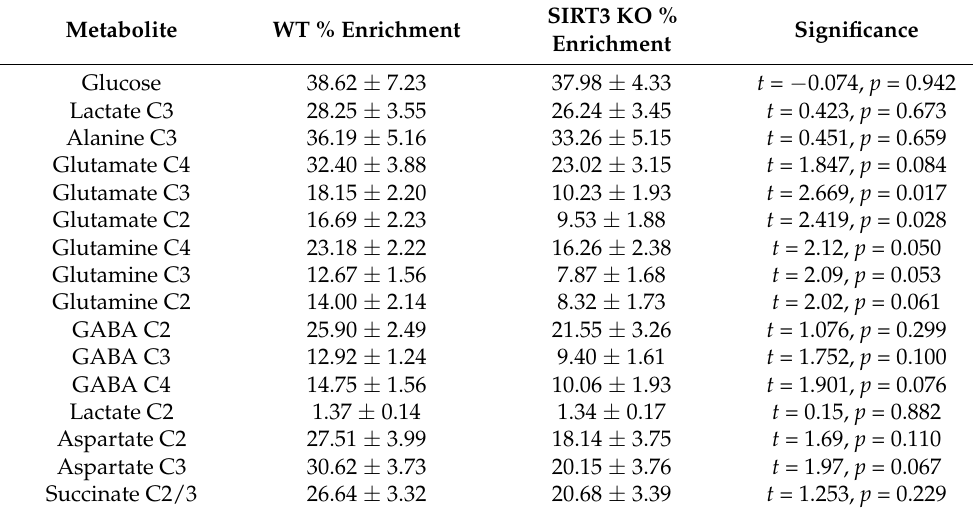
Table 1. Enrichment of newly synthesized metabolites in the brain from SIRT3 KO and WT